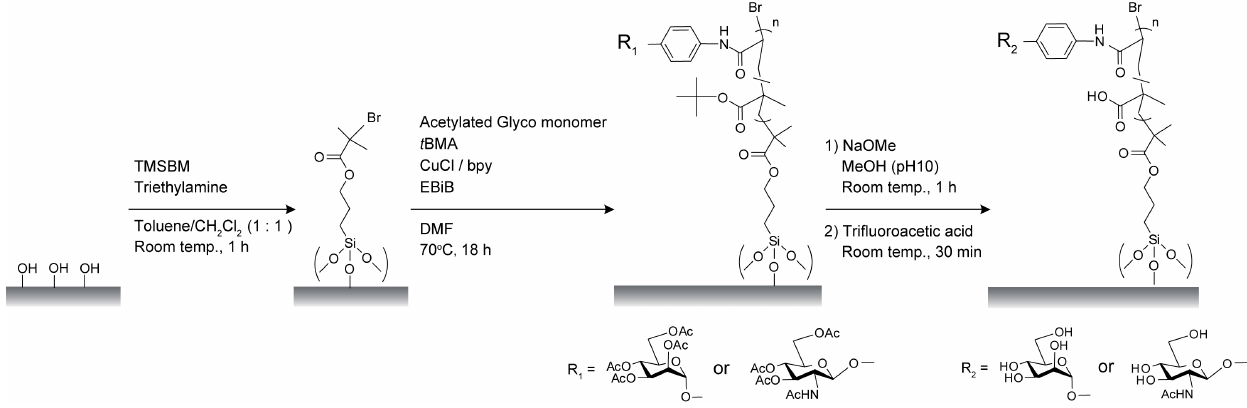
), number-average molecular weight ( M w